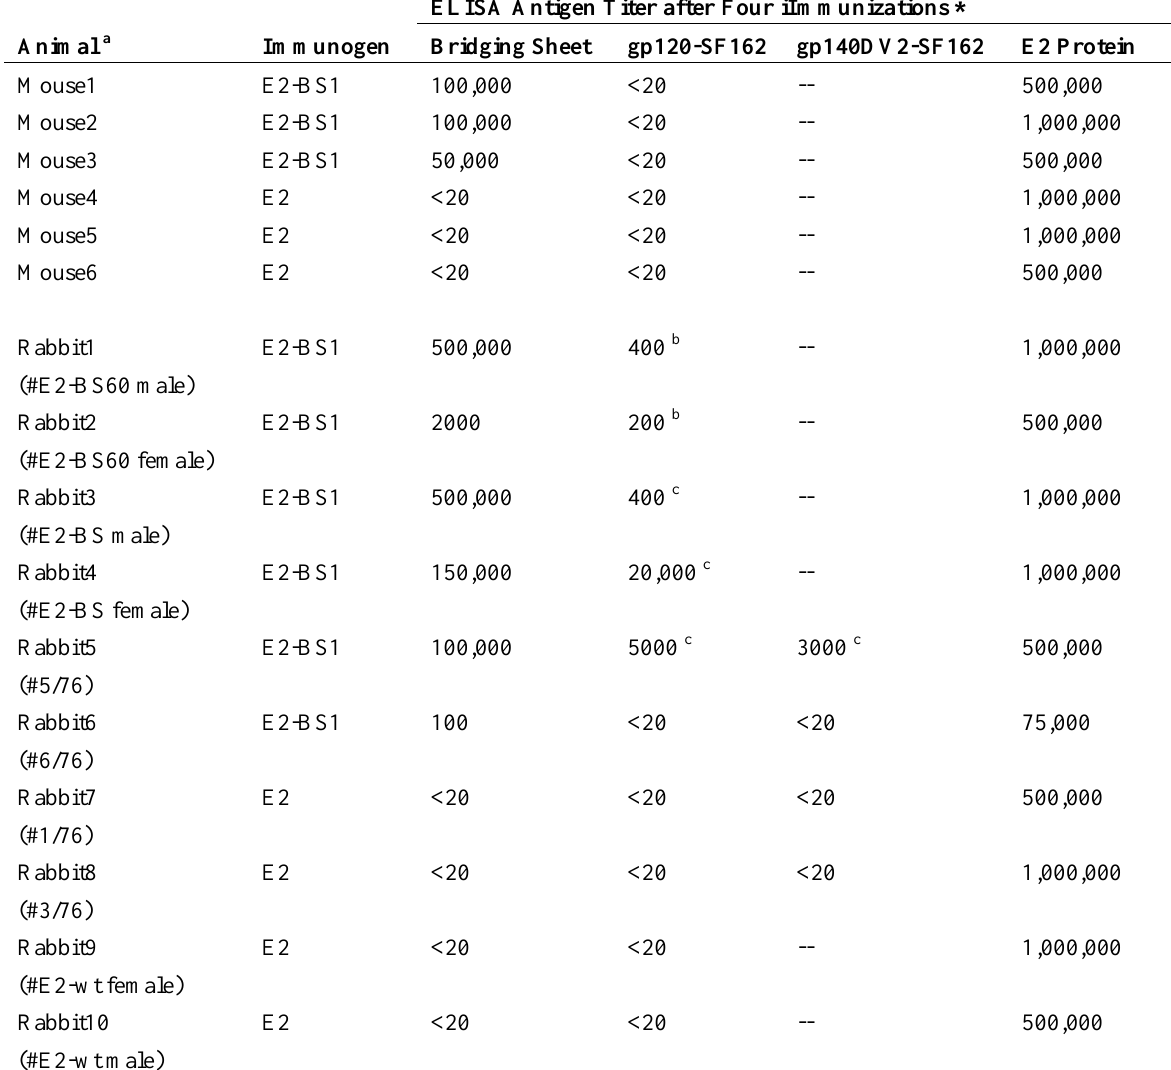
Table 1. End point titration against o- and m-Env of IgGs purified from mice and rabbit sera. Three indirect ELISA assays were performed to assess the cross-reactivity of mice and rabbits sera from animals immunized with E2-BS1 against monomeric (m) and oligomeric (o) gp120. The table reports end-point titers against BS1 mimotope, E2 protein carrier, m-gp120 SF162 and o-gp140  V2 SF162 for both mice and rabbits. Statistically